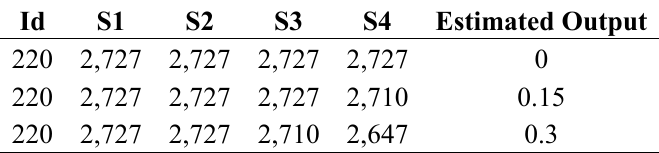
Table 3. Setting the estimate outputs where the transition between a lateral wall and a wall with zero degree orientation is taking place. S1, S2, S3, S4 and Id are given in